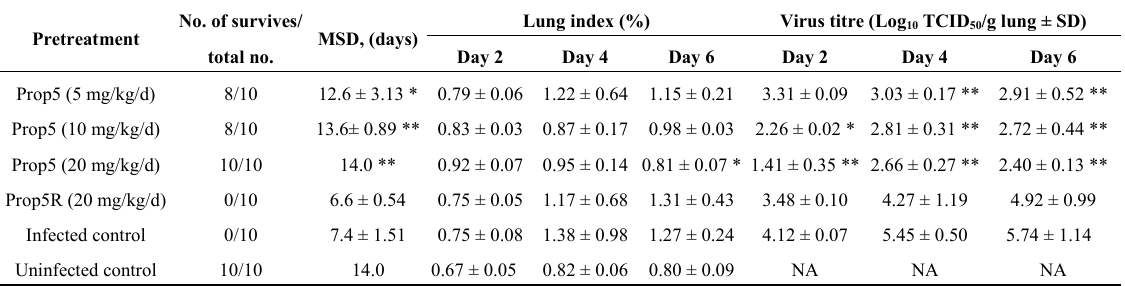
Table 1. Effects of intranasal pretreatment with prop5 on A/FM/1/47 (H1N1) infected mice. No. of survives/ Pretreatment